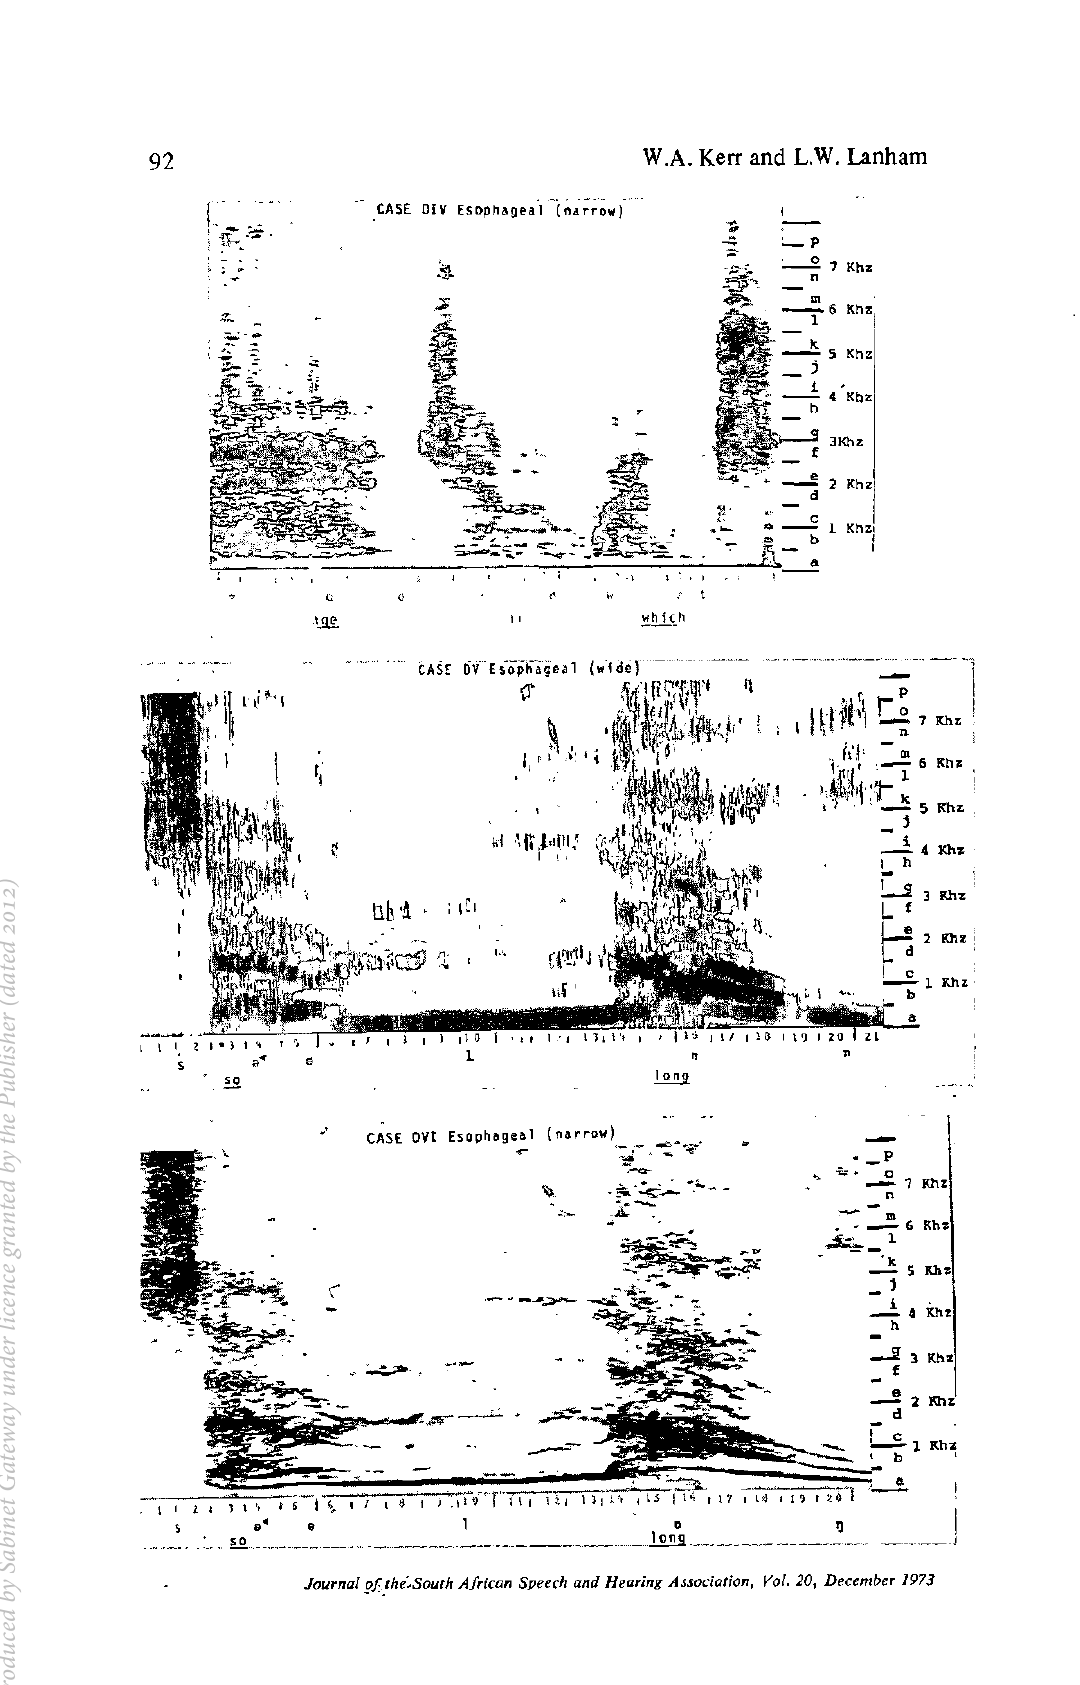
African Speech and Hearing Association, Vol. 20, December